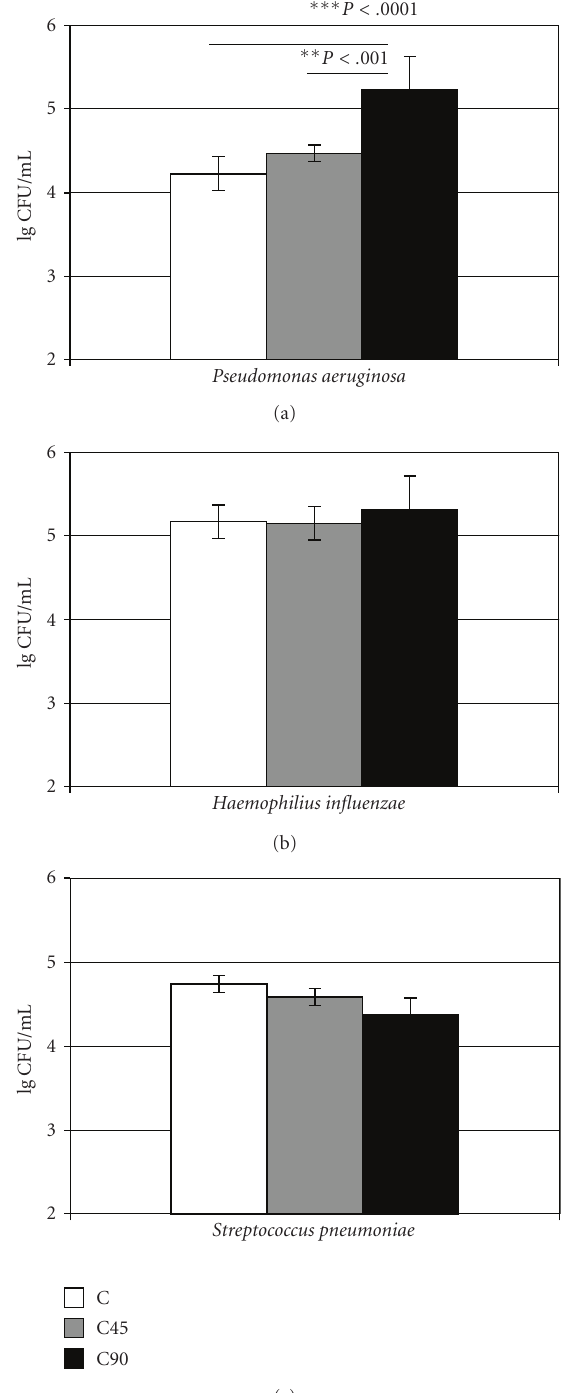
Figure 1: Attachment of (lg CFU/mL) P. aeruginosa (ATCC 27853) , H. influenzae (ATCC 49247), and S. pneumoniae (ATCC 49619) on the experimental materials C, C45, and